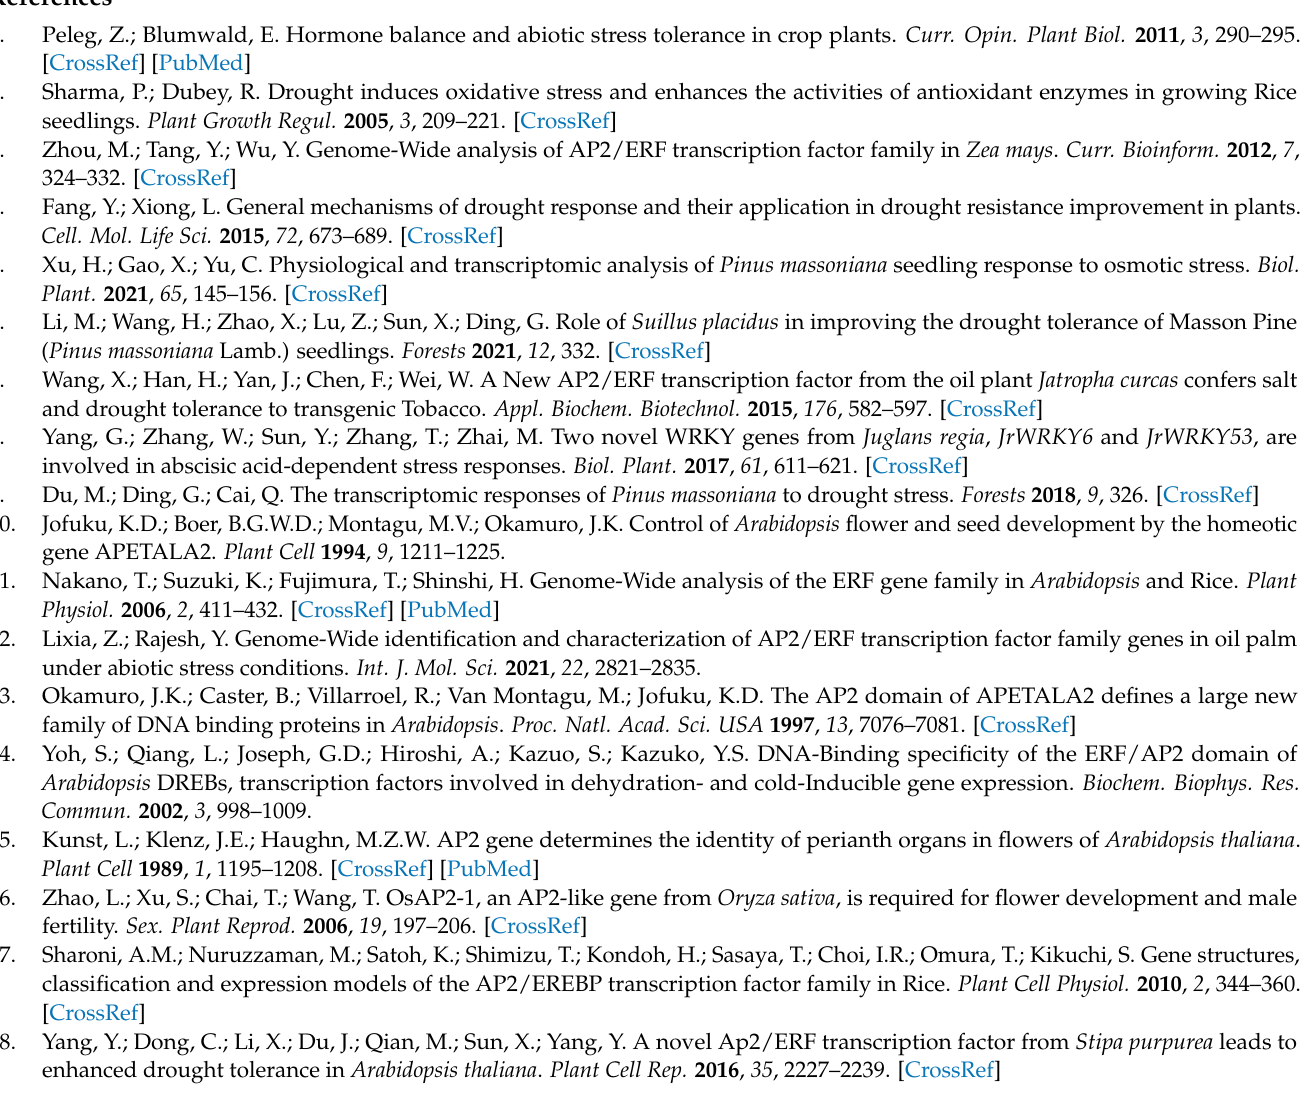
Table S2: Physical and chemical analysis of AP2/ERF in Pinus